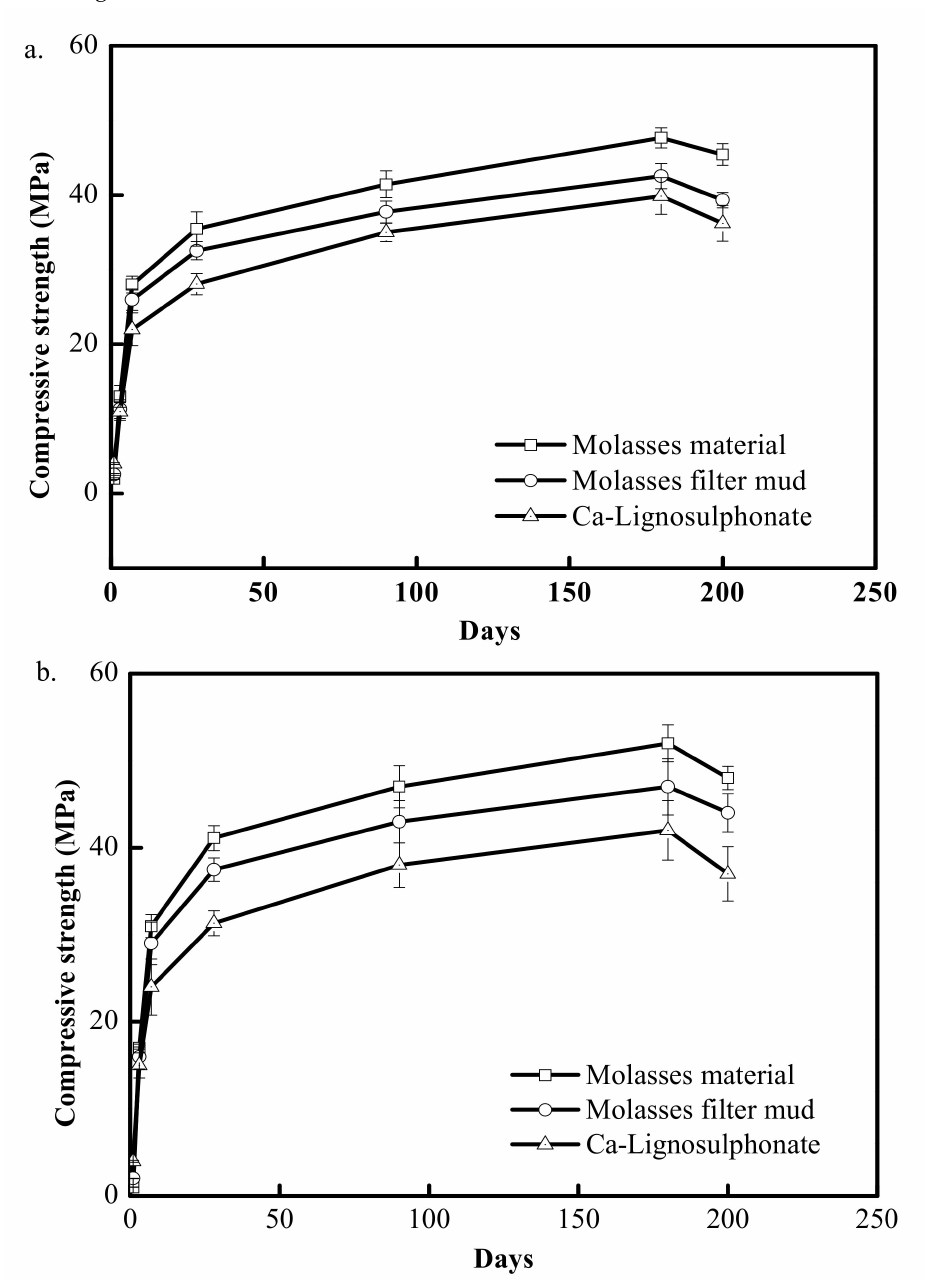
Figure 3. Effects of different additives on the cement compressive strength. ( a ) concrete with 0.2% retarder, ( b ) concrete with 0.4%